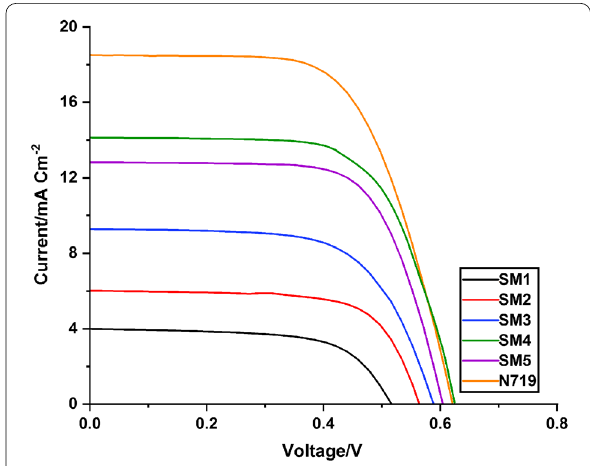
Fig. 9 J–V characteristics curves of the DSSCs fabricated using SM1-5 and